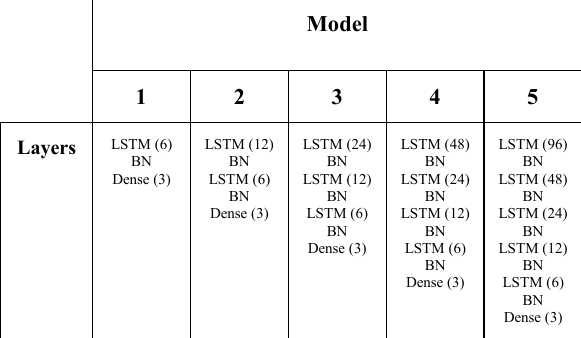
Table 1. Layers used in each model evaluated in the tenfold cross validation procedure. LSTM (n): Long-short term memory (number of units); BN: Batch normalisation; and Dense (n): Dense fully connected layer (number of output units).